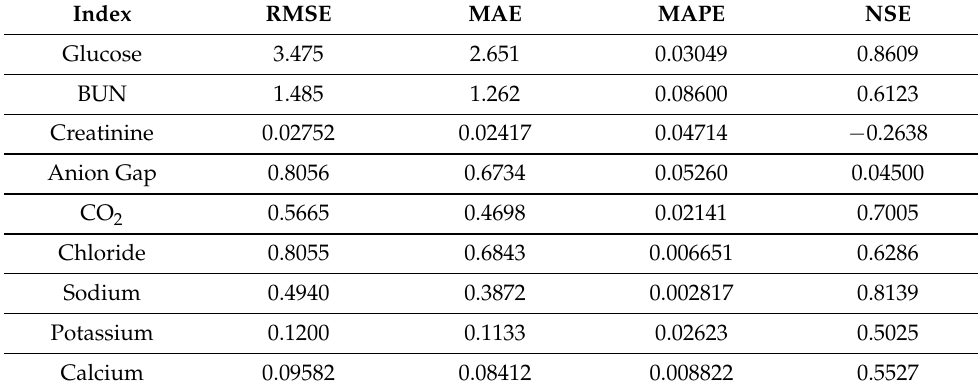
Table A6. Errors in other metrics of the one-step prediction of patient PH.